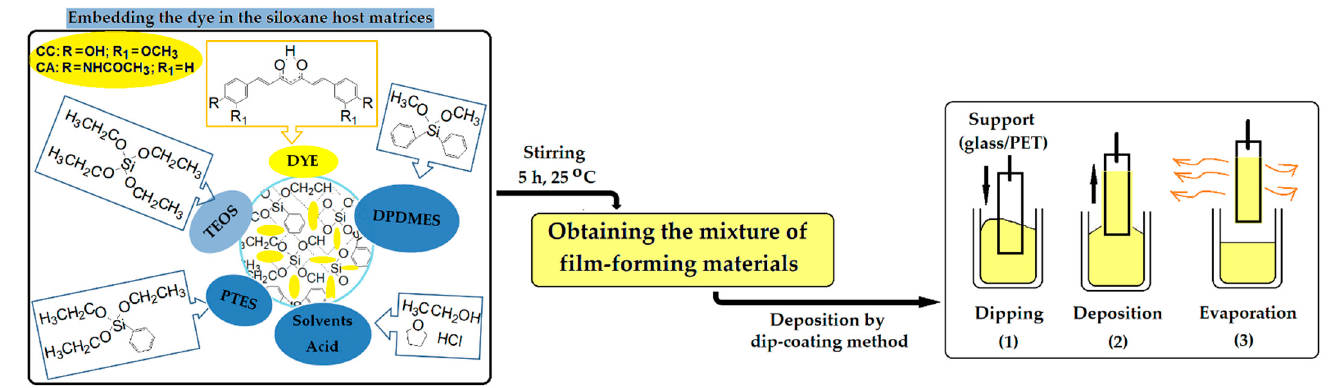
Figure 1. Synthesis of colored nanocomposites, based on siloxane polymer matrix and deposition of nanosols on the support (PET/glass) by dip-coating method.